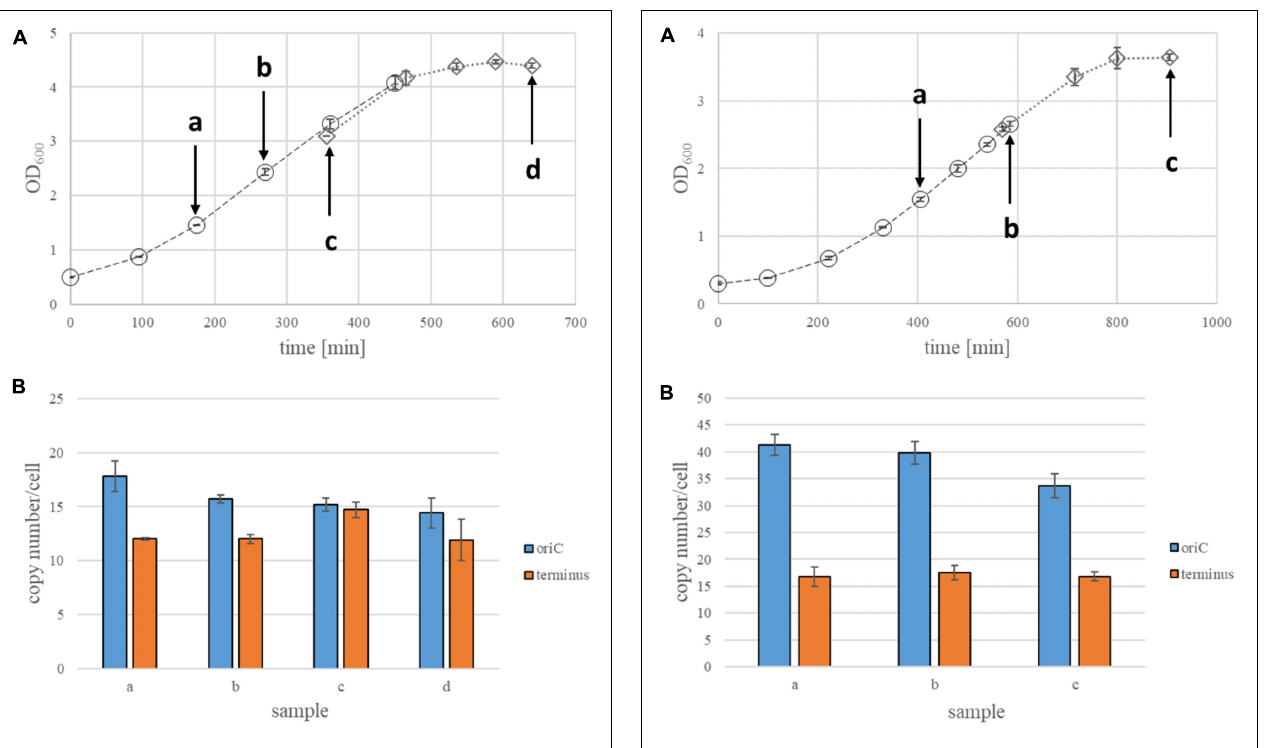
above). The origin/terminus ratios were 1.5 for strain Zm6G